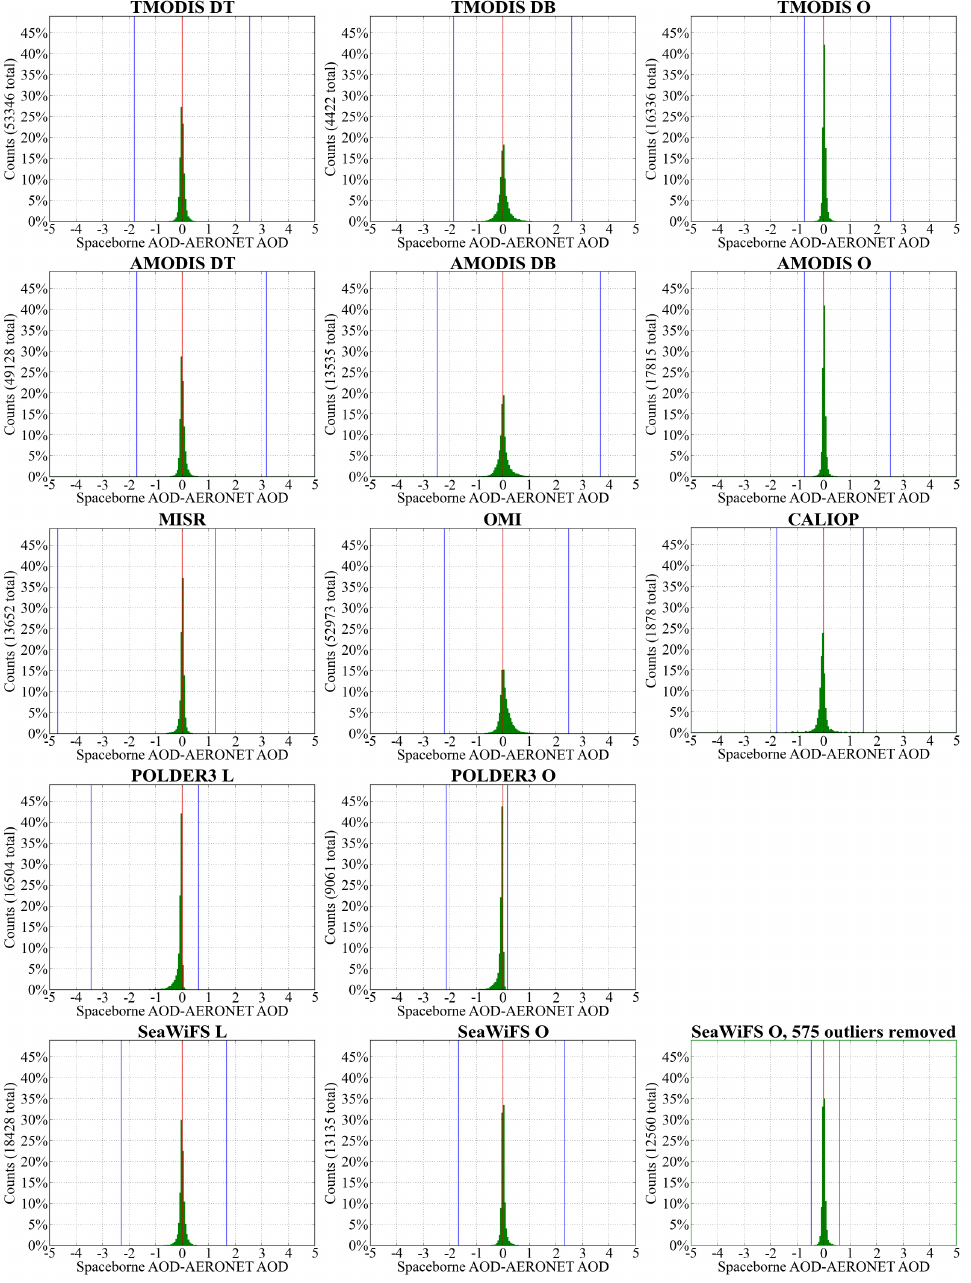
Figure 7. Distribution of the difference (residuals) between Spaceborne AOD and AERONET AOD. Satellite data were pre-screened by QA as explained in Sect. 4. In each histogram, the data are split into equal-length bins of 0.05 AOD. The red vertical line indicates the residual of 0 AOD, while the blue lines mark minimum and maximum residuals of each distribution. Histogram in the green frame demonstrates the results of the possible data outlier detection and removal procedure described in Section 5.